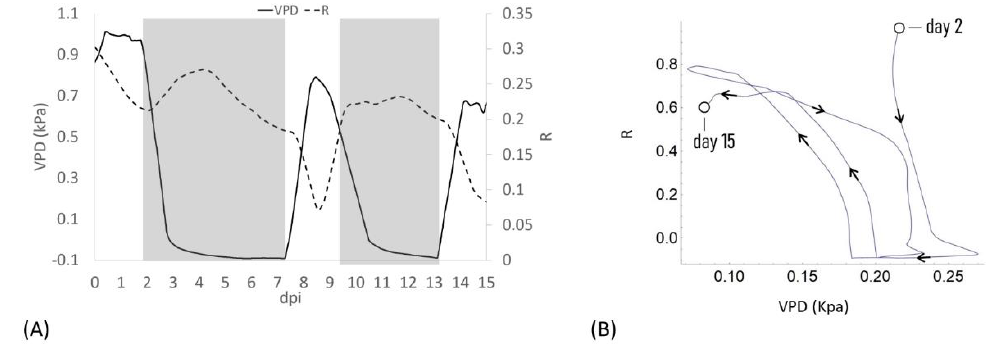
Figure 2. ( A ) Plot of the average of the R measured on all plants for all days post insertion (dpi) at Vg = 1 (dashed line) and the calculated VPD trend (solid line); ( B ) Diagram of the sensor response of the system (R) and the VPD reporting the trajectories described, the arrows indicate the direction of the curve from the beginning to the end of the experiment.